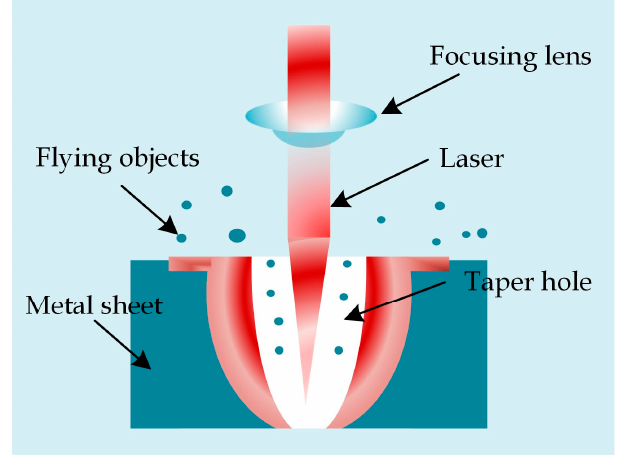
Figure 2. Schematic diagram of laser drilling.